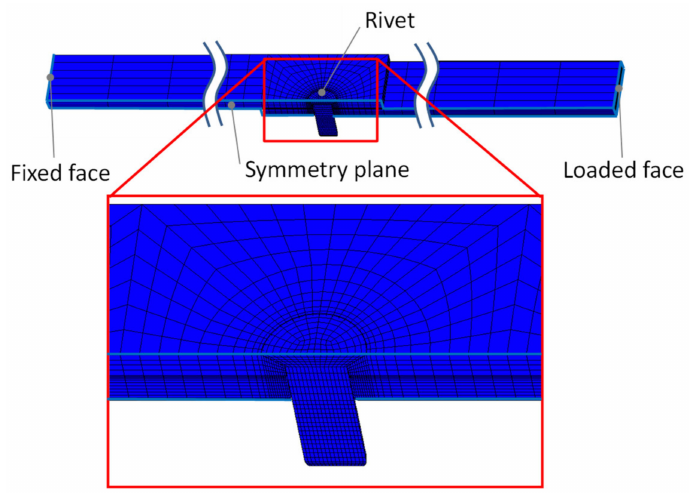
Figure 5. Detailed finite element model of a single-row